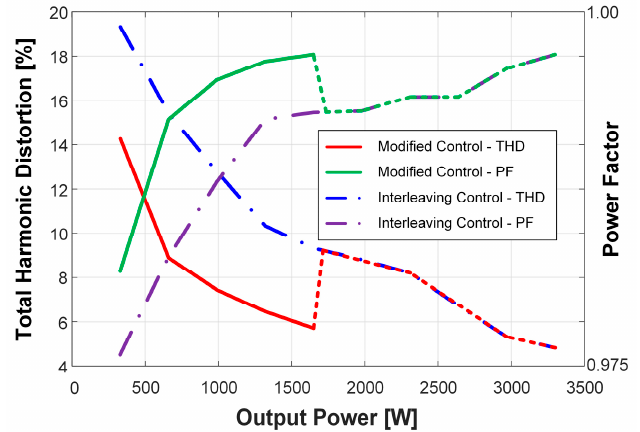
Figure 16. Measured power quality of the PFC stage with two controls. The measured condition is the same with the efficiency case.